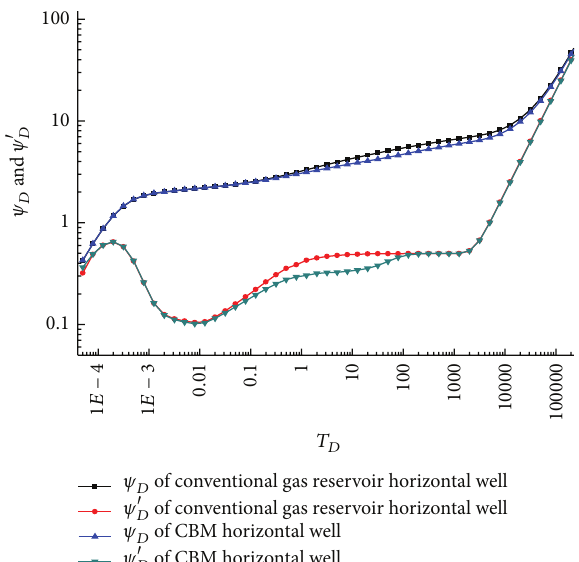
Figure 5: Comparison of typical curves between horizontal wells in CBM and conventional gas reservoirs.